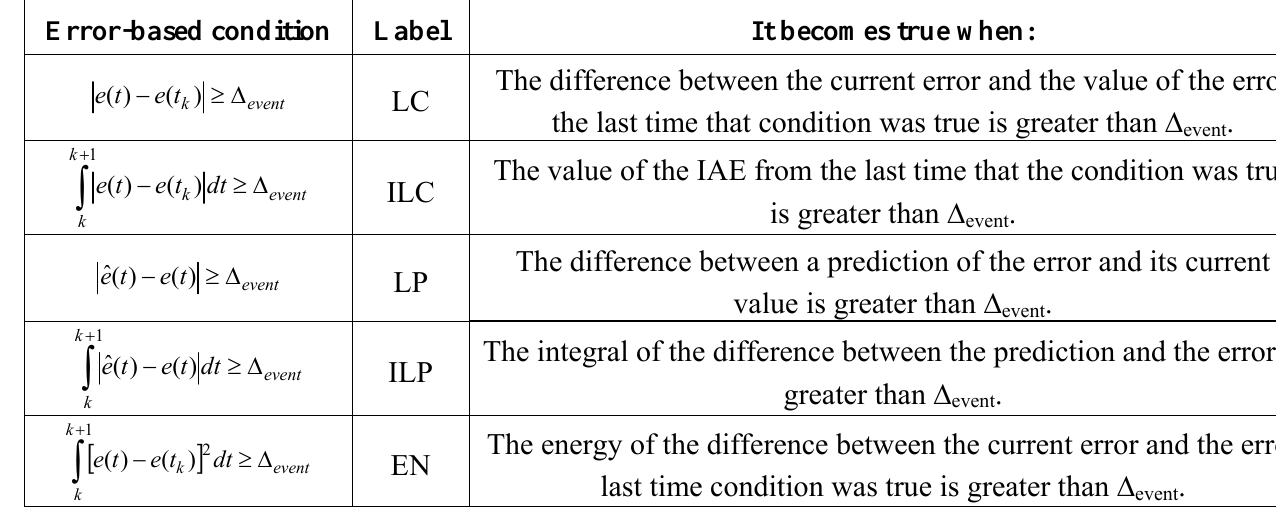
Table 3. Error-based conditions of the sampling strategy applied to the sensor. Error-based